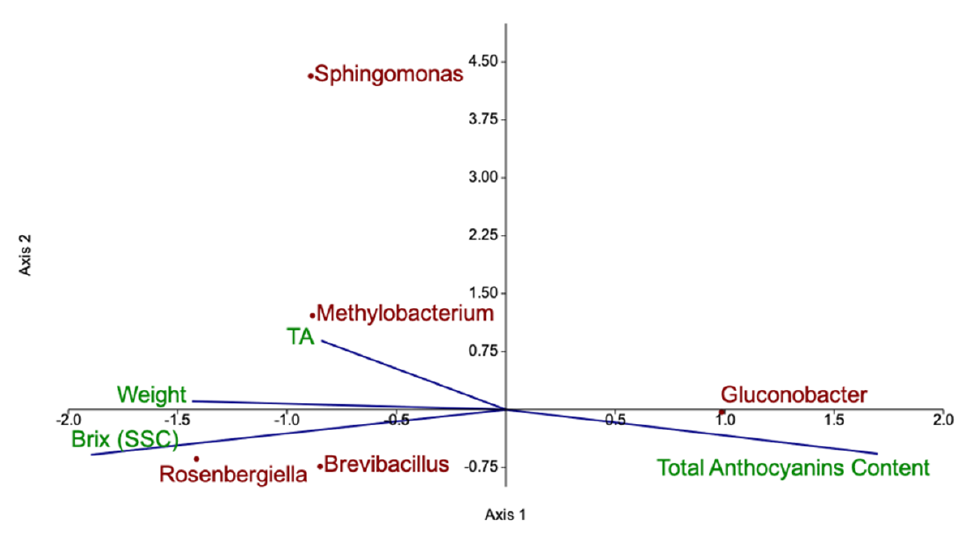
Figure 3. Main quality parameters ( a ), anthocyanidins content and color values ( b ) of raspberry fruit ‘Enrosadira’. Bars represent the mean ± SE. Different letters indicate significant differences between cultivation methods according to Student’s t -test at p -value < 0.05.